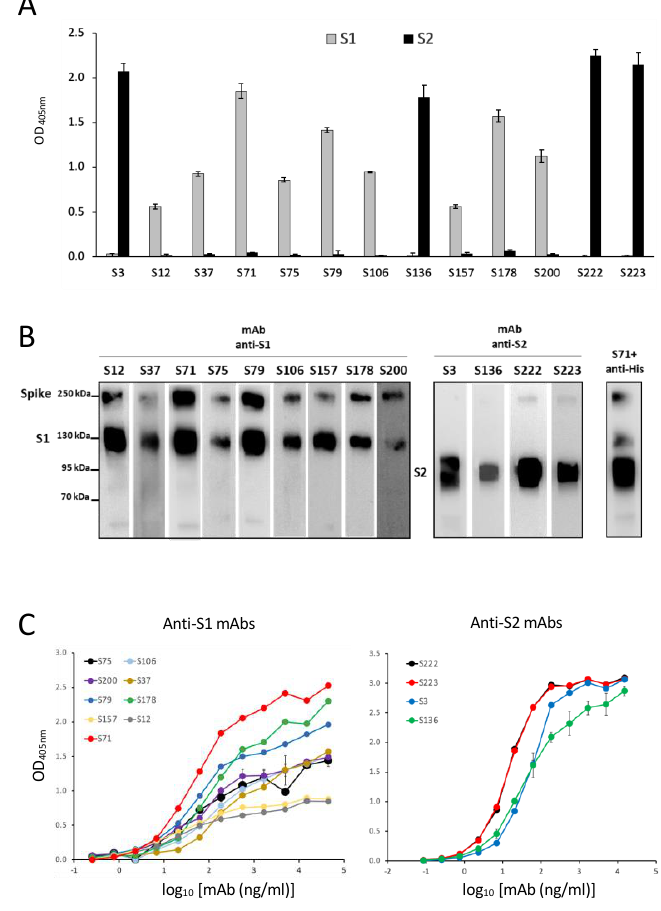
Figure 2. Isolated mAbs specific for SARS-CoV-2 Spike. ( A ) The binding of selected mAbs to the recombinant S1 or S2 domain produced in the mammalian expression system was evaluated by ELISA. Error bars indicate the standard deviations of technical duplicates from a representative experiment repeated three times. ( B ) WB analysis of anti-S1 and anti-S2 mAbs in SDS-PAGE supernatants of HEK293T cells transfected with pIgkS16–1182 ∆ TM. Anti-His antibody combined with anti-S1 S71 mAb was used as a positive control. ( C ) ELISA-binding affinity of the selected purified mAbs to the S1 (left panel) or to the S2 (right panel) domains produced in a mammalian expression system. Error bars indicate the standard deviations of technical duplicates from a representative experiment repeated twice. Table 3. IgG subclass, spike domain specificity, EC 50 and peptide recognition of isolated